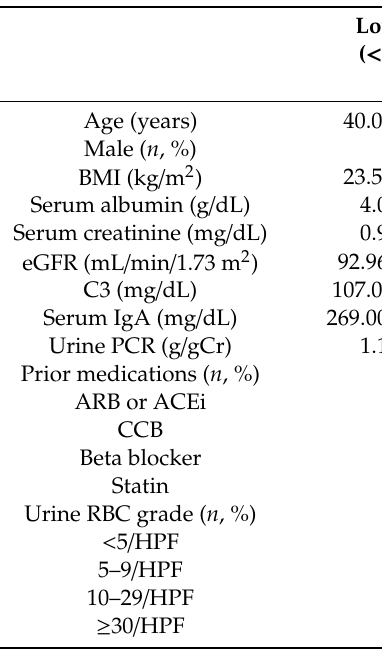
Table 3. Clinical characteristics of IgAN patients according to serum Gd-IgA1